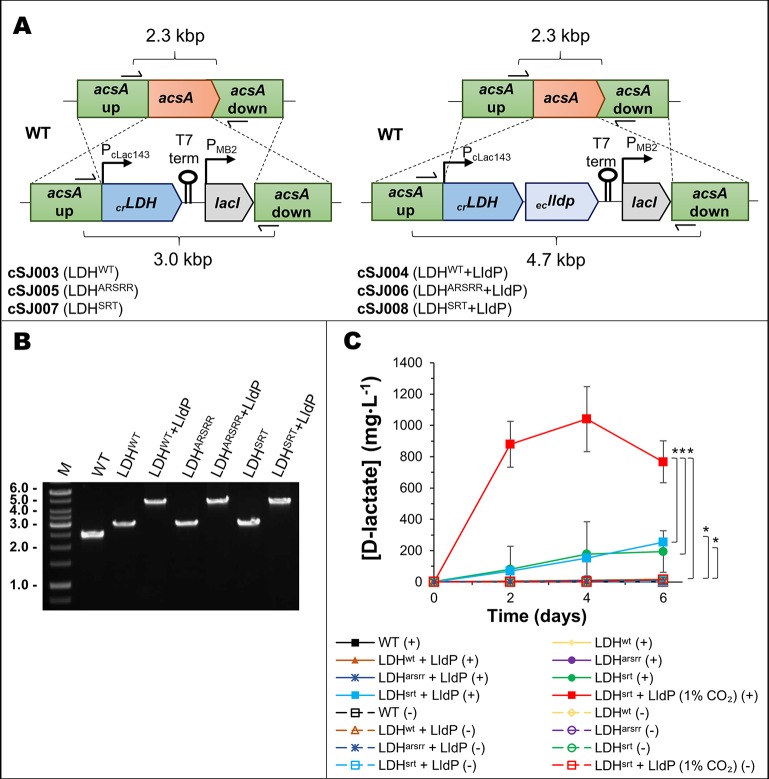
Cloning and production test of a mutated D-lactate dehydrogenase in Syn7002. (A) Schematic of the acsA gene locus modification in strains cSJ003/cSJ005/cSJ007 (left, with ldh gene only) and strains cSJ004/cSJ006/cSJ008 (right, with ldh and lldp genes in operon). Different components not to scale. (B) 1% agarose gel of colony PCR of the strains indicated, using primers shown in A). (C) D-lactate production test of the strains indicated, at 38°C, in either ambient air or 1% CO2, and a light intensity of 250 µmol photons·m-2·s-1. Error bars indicate a 95% confidence interval based on the standard error of the mean for triplicate cultures. Asterisks denote statistically relevant differences between indicated strains.